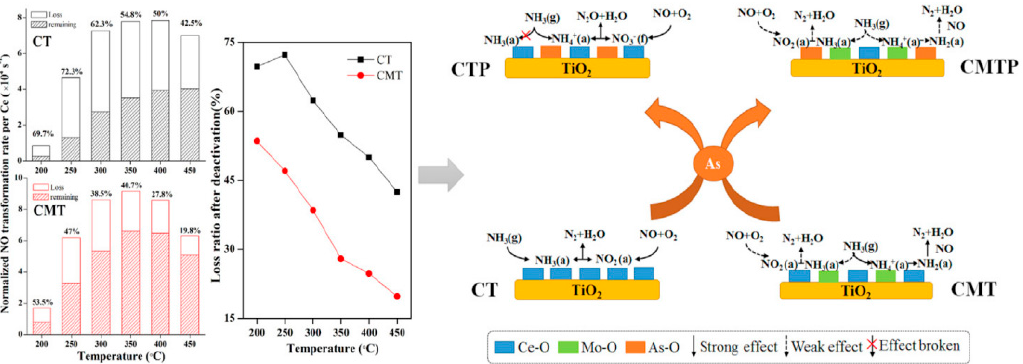
Figure 17. The performance of the arsenic resistance on MoO 3 doped CeO 2 /TiO 2 catalyst for SCR of NO x with ammonia [101].